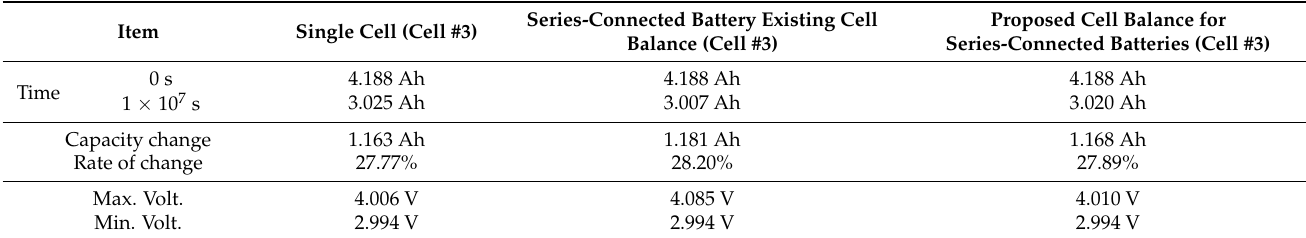
Table 8. Comparison of proposed cell balance with